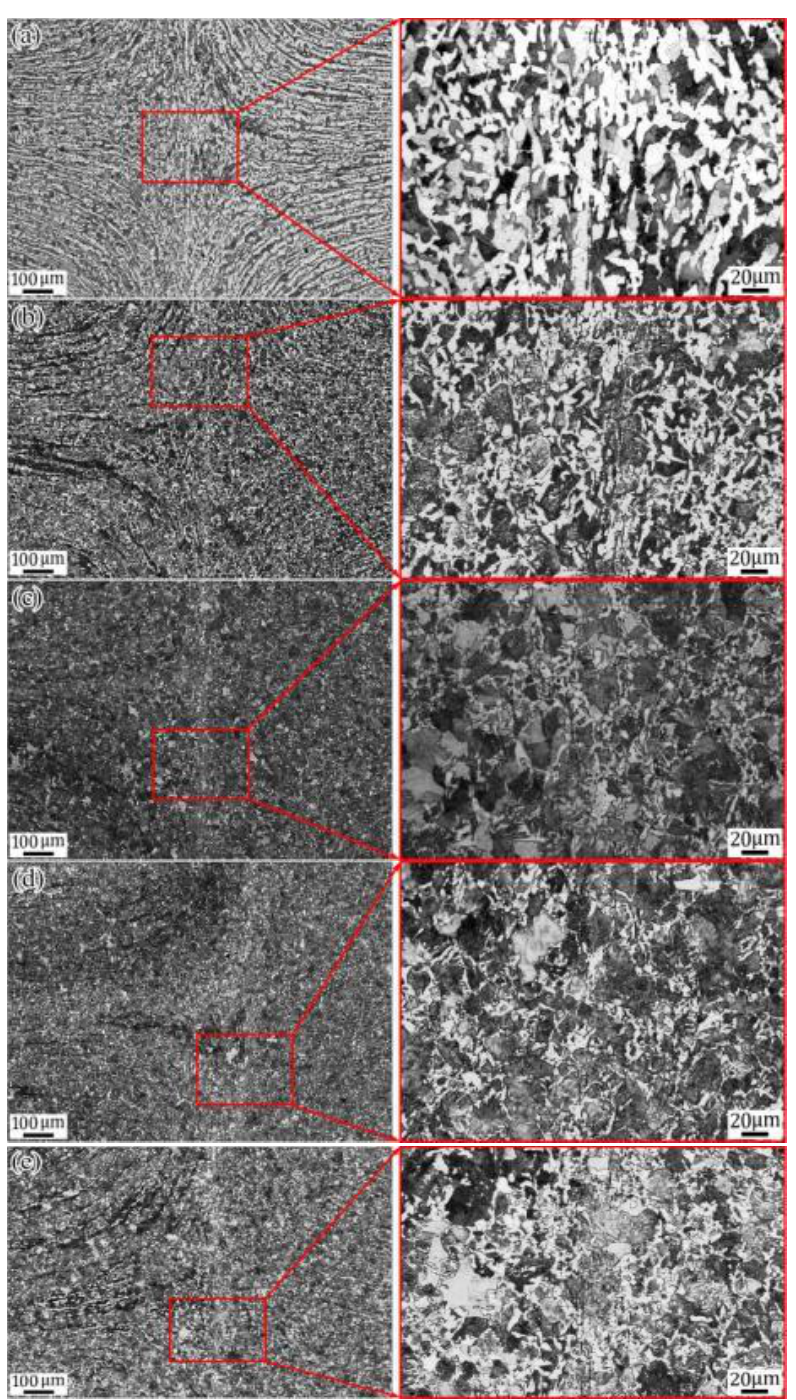
Figure 8. Optical microscope (OM) images of weld joint of steel pipes ( a ) P1#; ( b ) P2#; ( c ) P3#; ( d ) P4#; and ( e ) P5#.